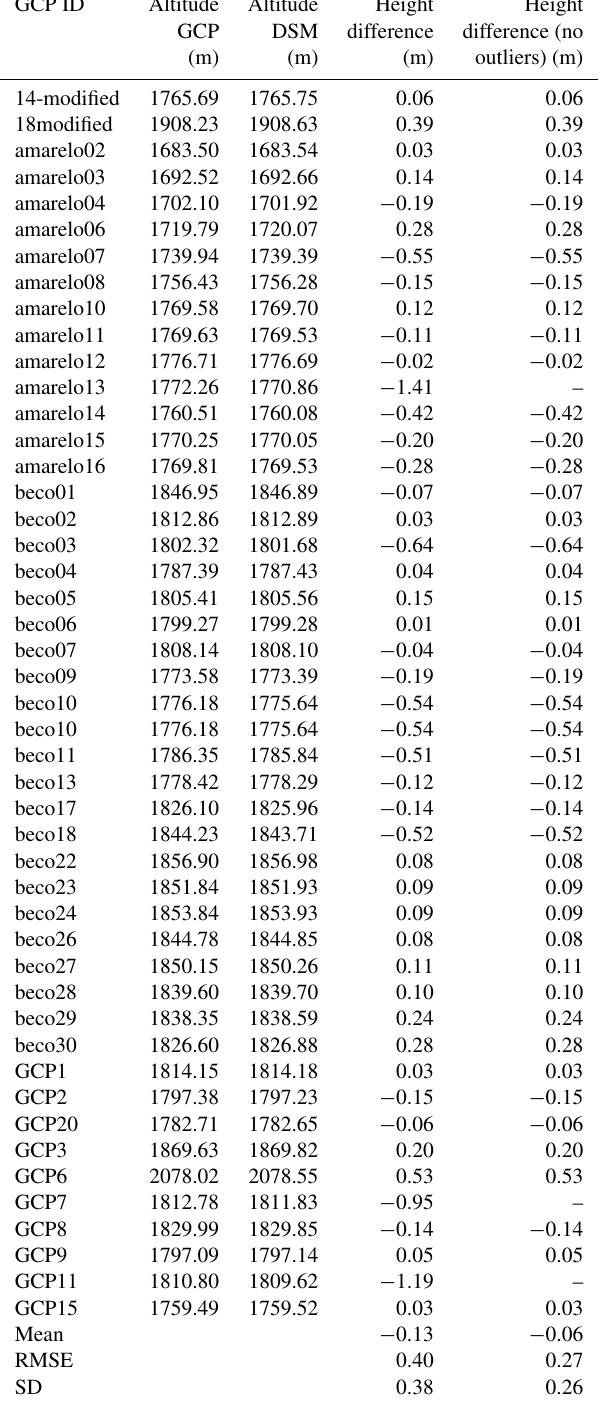
Table 4. Altitude differences between the digital surface model of the Chã das Caldeiras (25cm/pixel) and the ground control points measured with the differential GNSS in the field. GCP